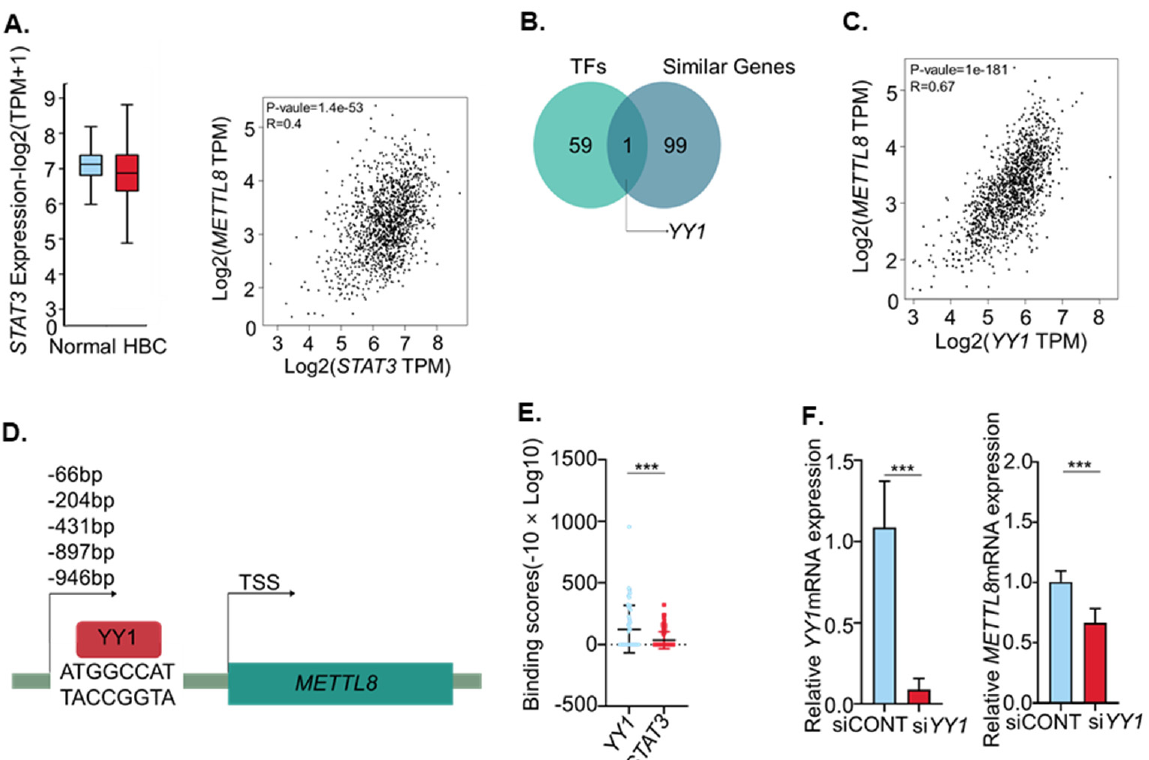
Figure 2. ( A ) Boxplot showing relative expression of STAT3 in breast cancer. The correlation between STAT3 and METTL8 expression in breast cancer was analyzed in gepia2 (http://gepia2.cancer-pku.cn; accessed on 20 May 2020). ( B ) Venn diagram showing the intersection of genes whose expression is genes similar in expression to expression of METTL8 in breast cancer from TCGA and/or GTEx expression data accessed via gepia2 (http://gepia2.cancer-pku.cn; accessed on 20 May 2020) with the genes identified as METTL8 putative transcription factors by PROMO (http://al- ggen.lsi.upc.es; accessed on 20 May 2020). ( C ) The correlation between YY1 and METTL8 expres- sion in breast cancer was analyzed in gepia2 (http://gepia2.cancer-pku.cn; accessed on 20 May 2020). ( E ) Peak-call data of the same antigens were collected from public datasets, and MACS2 scores ( − 10 × Log10 (MACS2 Q-value)) are displayed binding scores for METTL8. ( F ) YY1 and METTL8 mRNA levels were analyzed by RT-qPCR 48 h after YY1 knocked-down in MDA-MB-231 cells as compared with the control. *** indicates p < 0.001, HBC: human breast cancer.